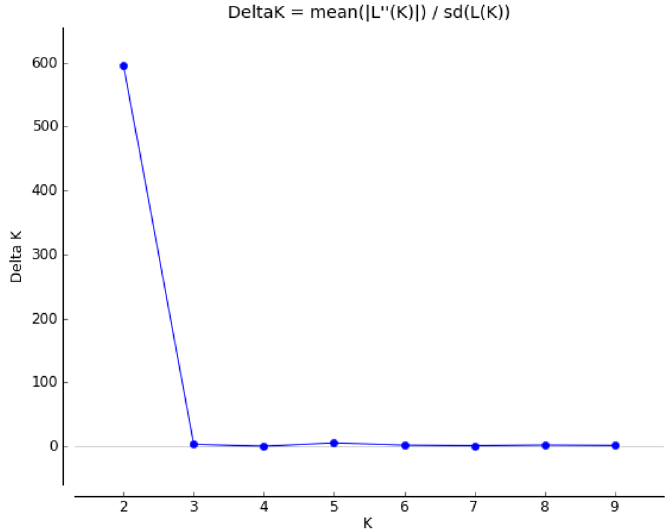
Figure 3. Value of Delta K ( ∆ K) for determining the optimum number of subpopulations.